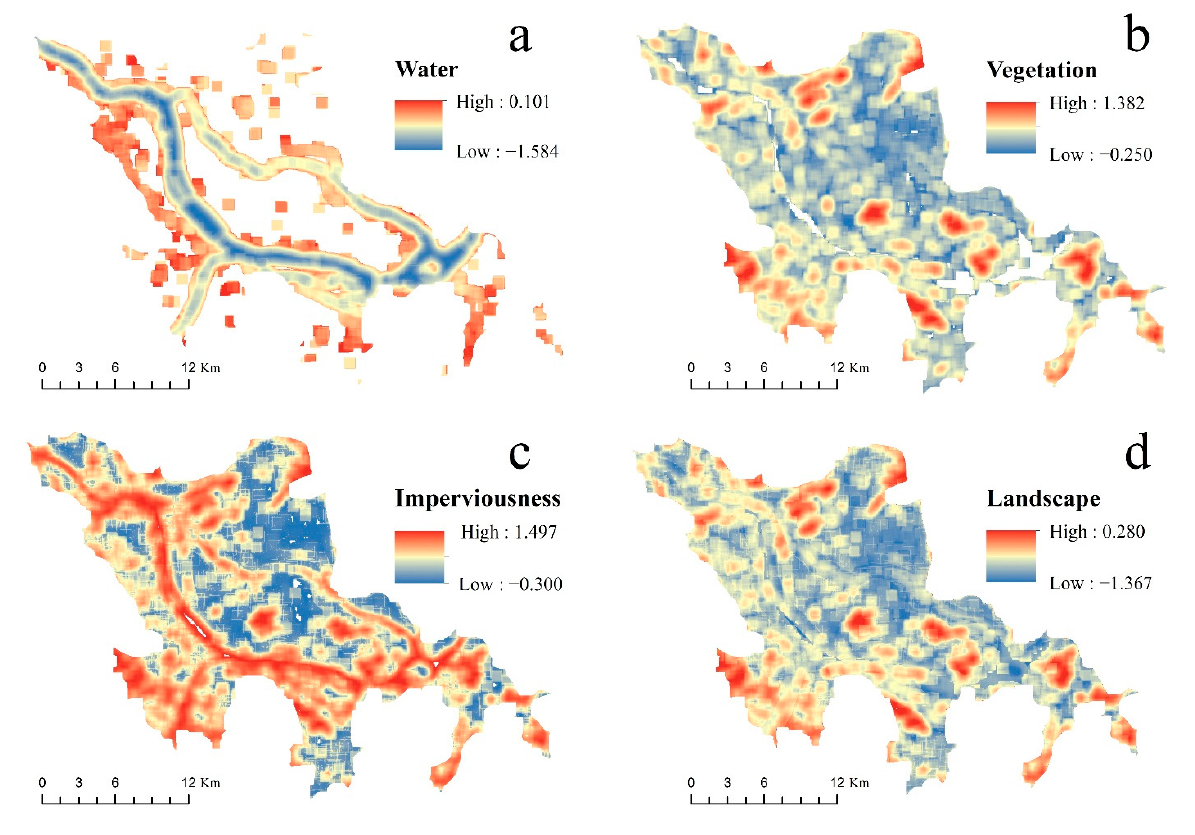
Figure 8. Spatial distribution of landscape pattern. ( a ) is the water landscape comprehensive index; ( b ) is the vegetation landscape comprehensive index; ( c ) is the imperviousness landscape comprehensive index; ( d ) is the landscape pattern comprehensive index.